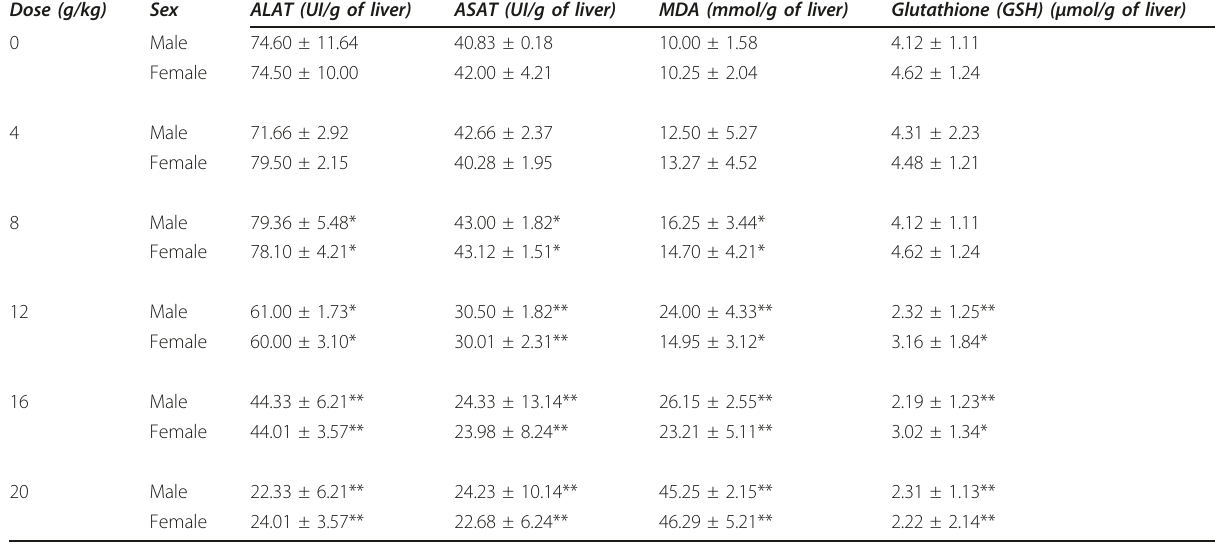
Table 7 Effect of the methanolic extract of Phyllanthus muellerianus on different liver biochemical parameters of male and female